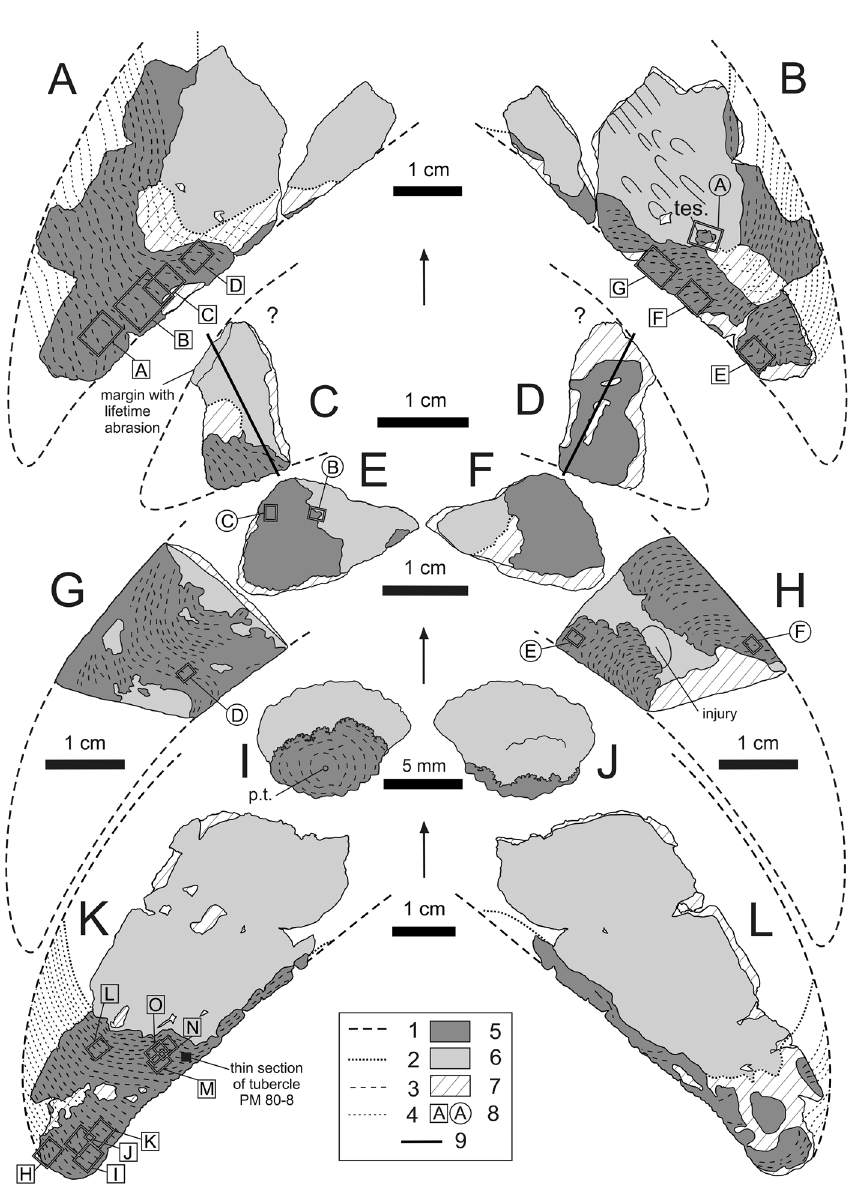
Fig. 3. Psammosteus ramosus sp. nov. Glinskiy, schematic drawings with positions of detail photographs in Figs 4, 5. A , B , PM SPU 80-2, holotype, fragment of left branchial plate. C , D , PM SPU 80-3, fragment of left branchial plate. E , F , G 43/292:1, fragment of branchial plate. G , H , G 43/292:2, fragment of left branchial plate. I , J , PM SPU 80-4, lateral scale. K , L , PM SPU 80-1, fragment of left branchial plate. Abbreviations: arrow indicates the anterior direction; p.t., primordial tubercle; tes, rooted tesserae; 1, supposed contour line of the plates; 2, supposed margin of the ornamented surface; 3, growth line; 4, supposed growth line; 5, ornamented surface; 6, unornamented surface; 7, destroyed parts of the plate; 8, letters inside a square indicate the photographs in Fig. 4, whereas those inside a circle indicate the photographs in Fig. 5; 9, the line in bold in the figures C, D is a line of the vertical thin section, which is shown in Fig. 7D. Fig. 2. Psammosteus ramosus sp. nov. Glinskiy, branchial plates and a lateral scale from the Amata RS, Upper Devonian. A – C , PM SPU 80-2, holotype, fragment of left branchial plate, Andoma Hill, Russia; A, dorsal, B, ventral and C, posterior views. D – F , PM SPU 80-3, fragment of left branchial plate, Andoma Hill, Russia; D, dorsal, E, ventral and F, posterior views. G – K , G 43/292:2, fragment of left branchial plate, Ķūķ u, Latvia; G, dorsal, H, ventral, I, anterolateral, J, posterior and K, across views. L , M , G 43/292:1, fragment of branchial plate, Ķūķ u, Latvia; L, ventral? and M, dorsal? views. N – P , PM SPU 80-1, fragment of left branchial plate, Borschovo, Russia; N, dorsal, O, ventral and P, posterior views. Q , R , PM SPU 80-4, lateral scale, Andoma Hill, Russia; Q, external and R, visceral views. Q, R, SEM SE